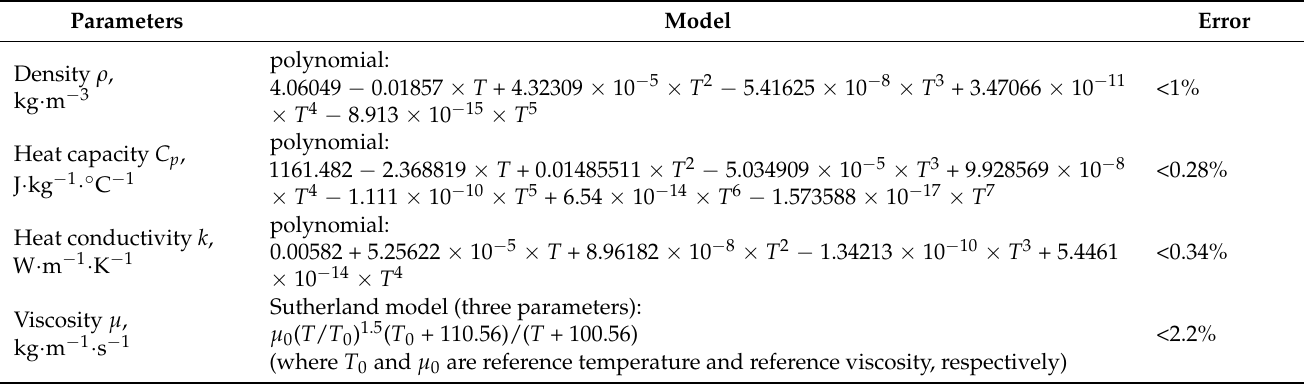
Table 4. Thermal properties of air parameters.